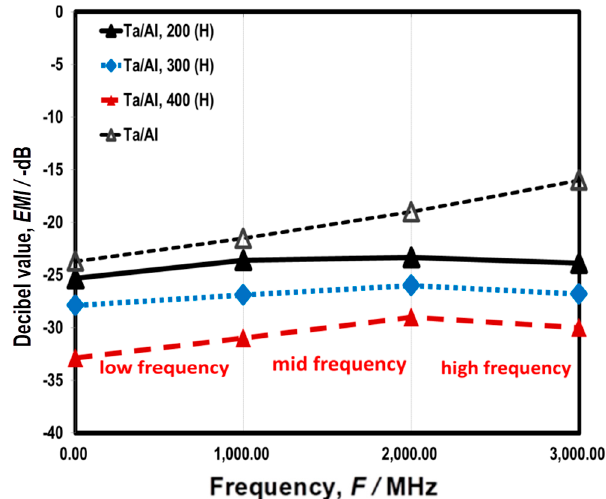
Figure 9. EMI shielding characteristics of un-annealed and annealed specimens: Ta (200 nm)/Al (50 nm)/glass, 25 °C, RH = 50%.